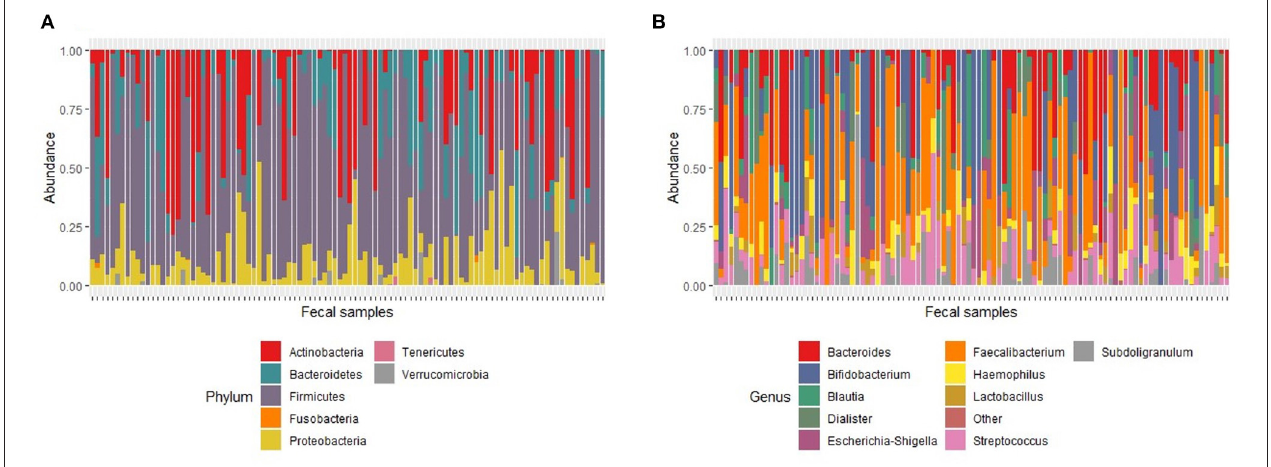
FIGURE 2 | Relative abundance of major taxa found in fecal samples at baseline. (A) . Major phyla. The proportion of total number of reads for each phylum in a sample represents phylum abundance after rarefaction to 1000 reads. (B) Major genera. The proportion of total number of reads for each genus in a